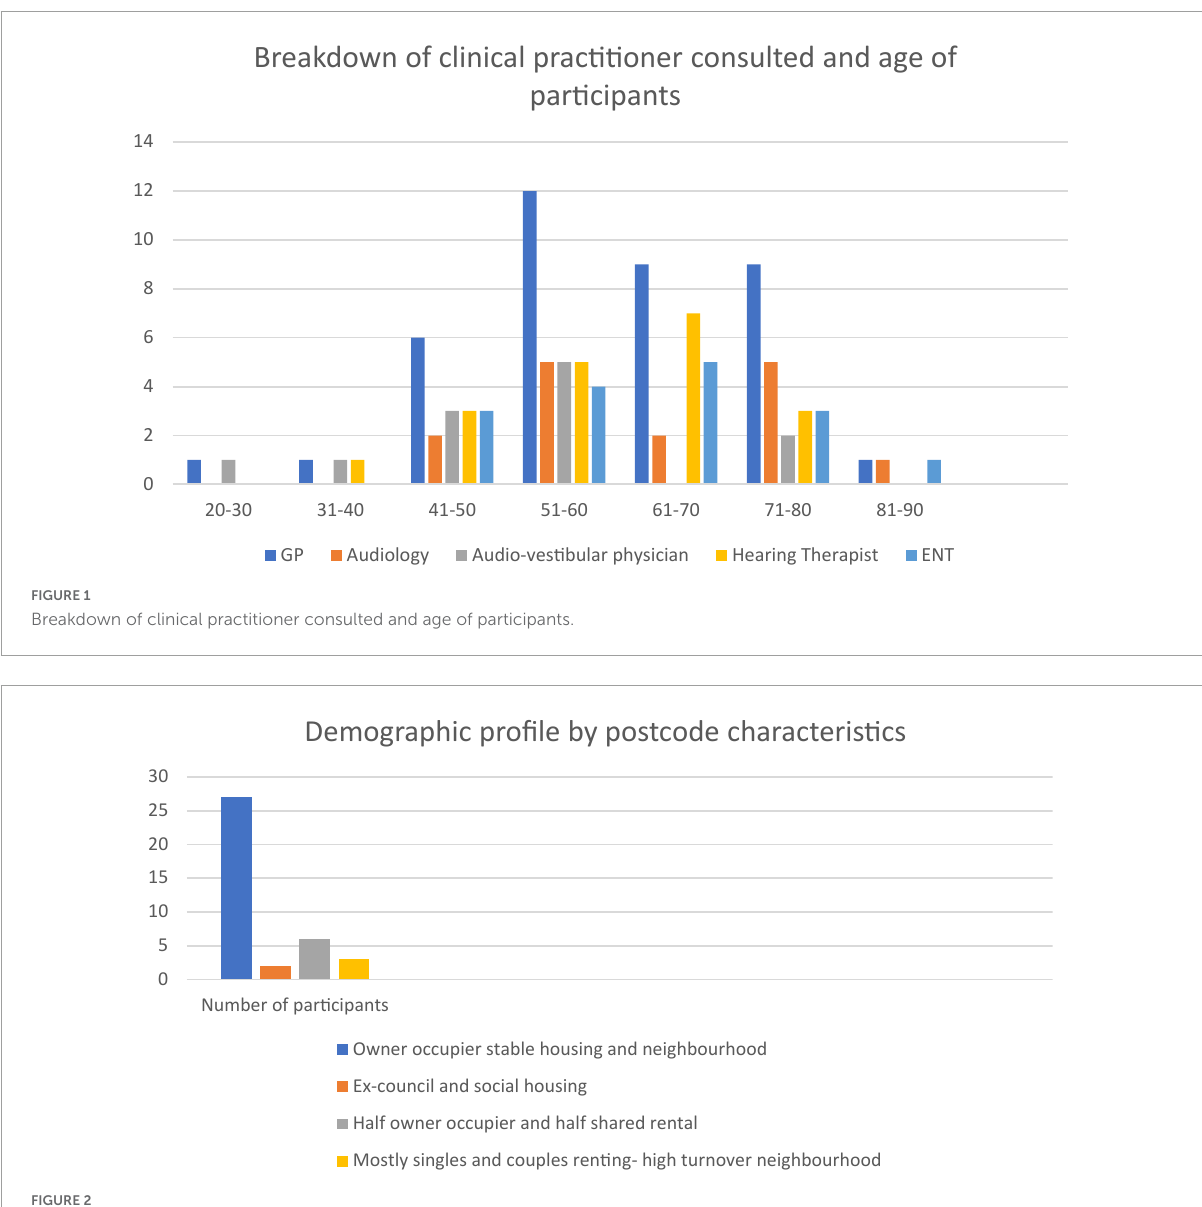
FIGURE2 Demographic profile by postcode